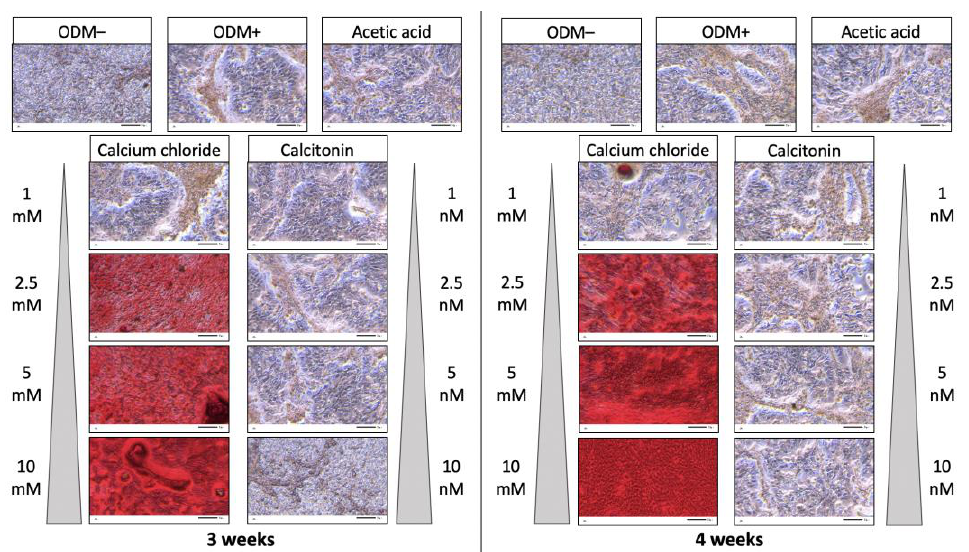
Figure 3. Alizarin red S staining of human osteoblasts (SaOs-2) after incubation with calcium chloride or calcitonin. Cells were incubated with increasing calcium chloride (1, 2.5, 5, and 10 mM) or calcitonin (1, 2.5, 5, and 10 nM) concentrations for three ( left panel) and four weeks ( right panel), and subsequently stained with alizarin red S. Each condition was assessed in triplicate in three independent experiments (n = 9). ODM− served as a negative control (n = 6), ODM+ (n = 12) as reference, and acetic acid (n = 6) was used as an additional control as calcitonin was dissolved in acetic acid. Representative pictures of transmitted light microscopy at 20x magnification are shown. Scale